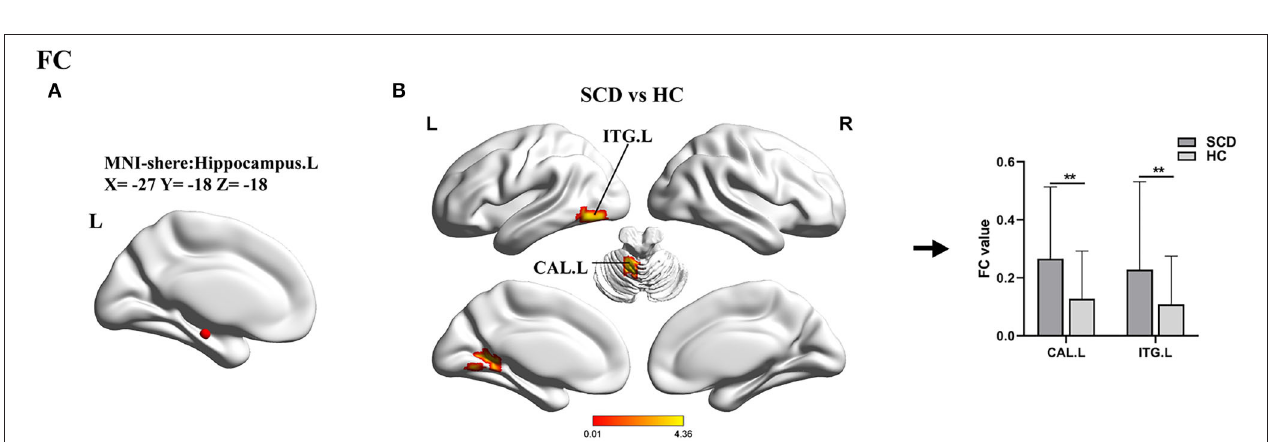
FIGURE 4 | Results of the FC analyses with the hippocampus.L as a seed. (A) Shows the distribution of the seed. (B) Shows results of a two-sample t -test between SCD and HC (**TFCE-FEW corrected, p < 0.005, the cluster size > 50 voxels). FC, functional connectivity; SCD, subjective cognitive decline; HC, healthy control; ITG, inferior temporal gyrus; CAL, cerebellum anterior lobe; L, left; R, right.